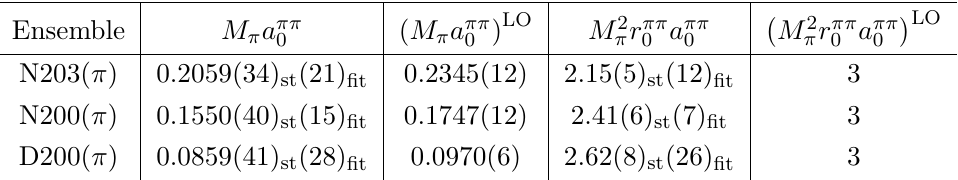
Table 15. Two-pion threshold parameters used for chiral fits, obtained as described in the text, along with the leading-order predictions of ChPT.